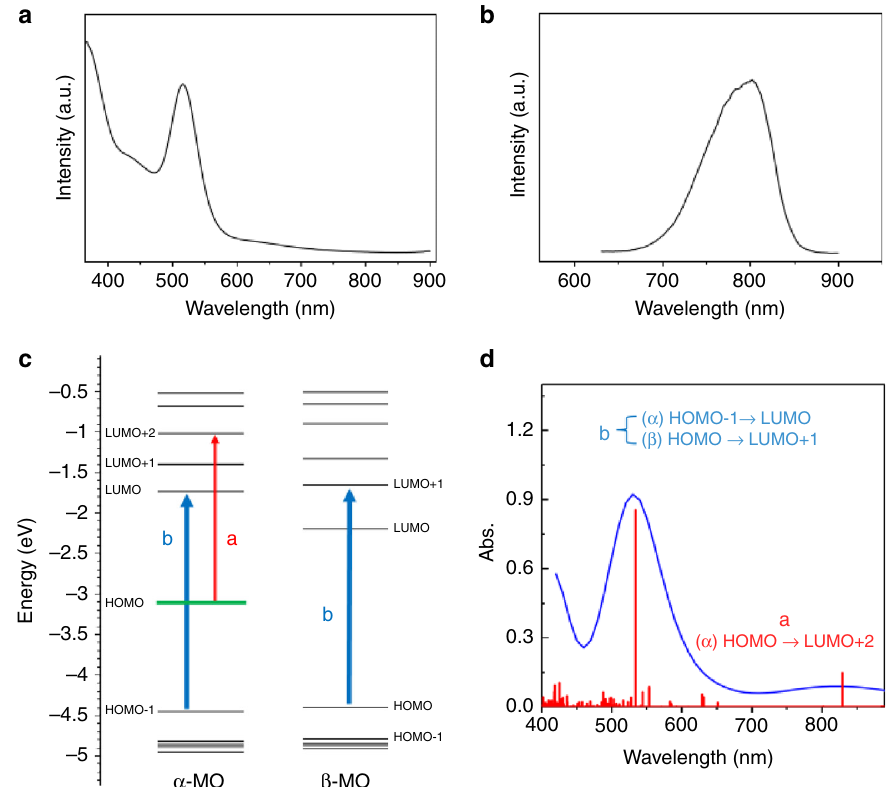
Fig. 4 Optical properties and DFT simulation of the Ag 23 nanocluster. a UV-vis absorption and b emission ( λ ex = 540 nm and slit width = 5 nm) spectra of Ag 23 (PPh 3 ) 8 (SC 2 H 4 Ph) 18 nanoclusters in a solution of CH 2 Cl 2 . c Energy alignment of the MOs and d theoretical absorption spectrum of Ag 23 (PH 3 ) 8 (SCH 3 )